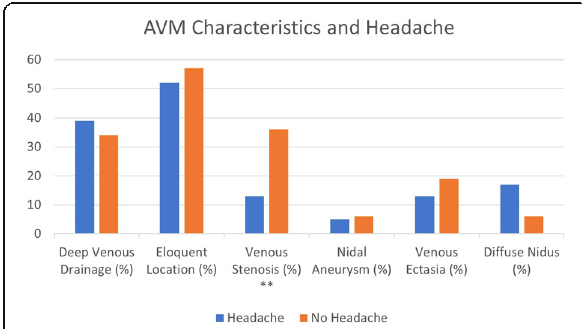
Fig. 1 Bar graph representation of angioarchitectural characteristics demonstrated in headache and non-headache presentations of unruptured AVMs. ** indicates significant findings.